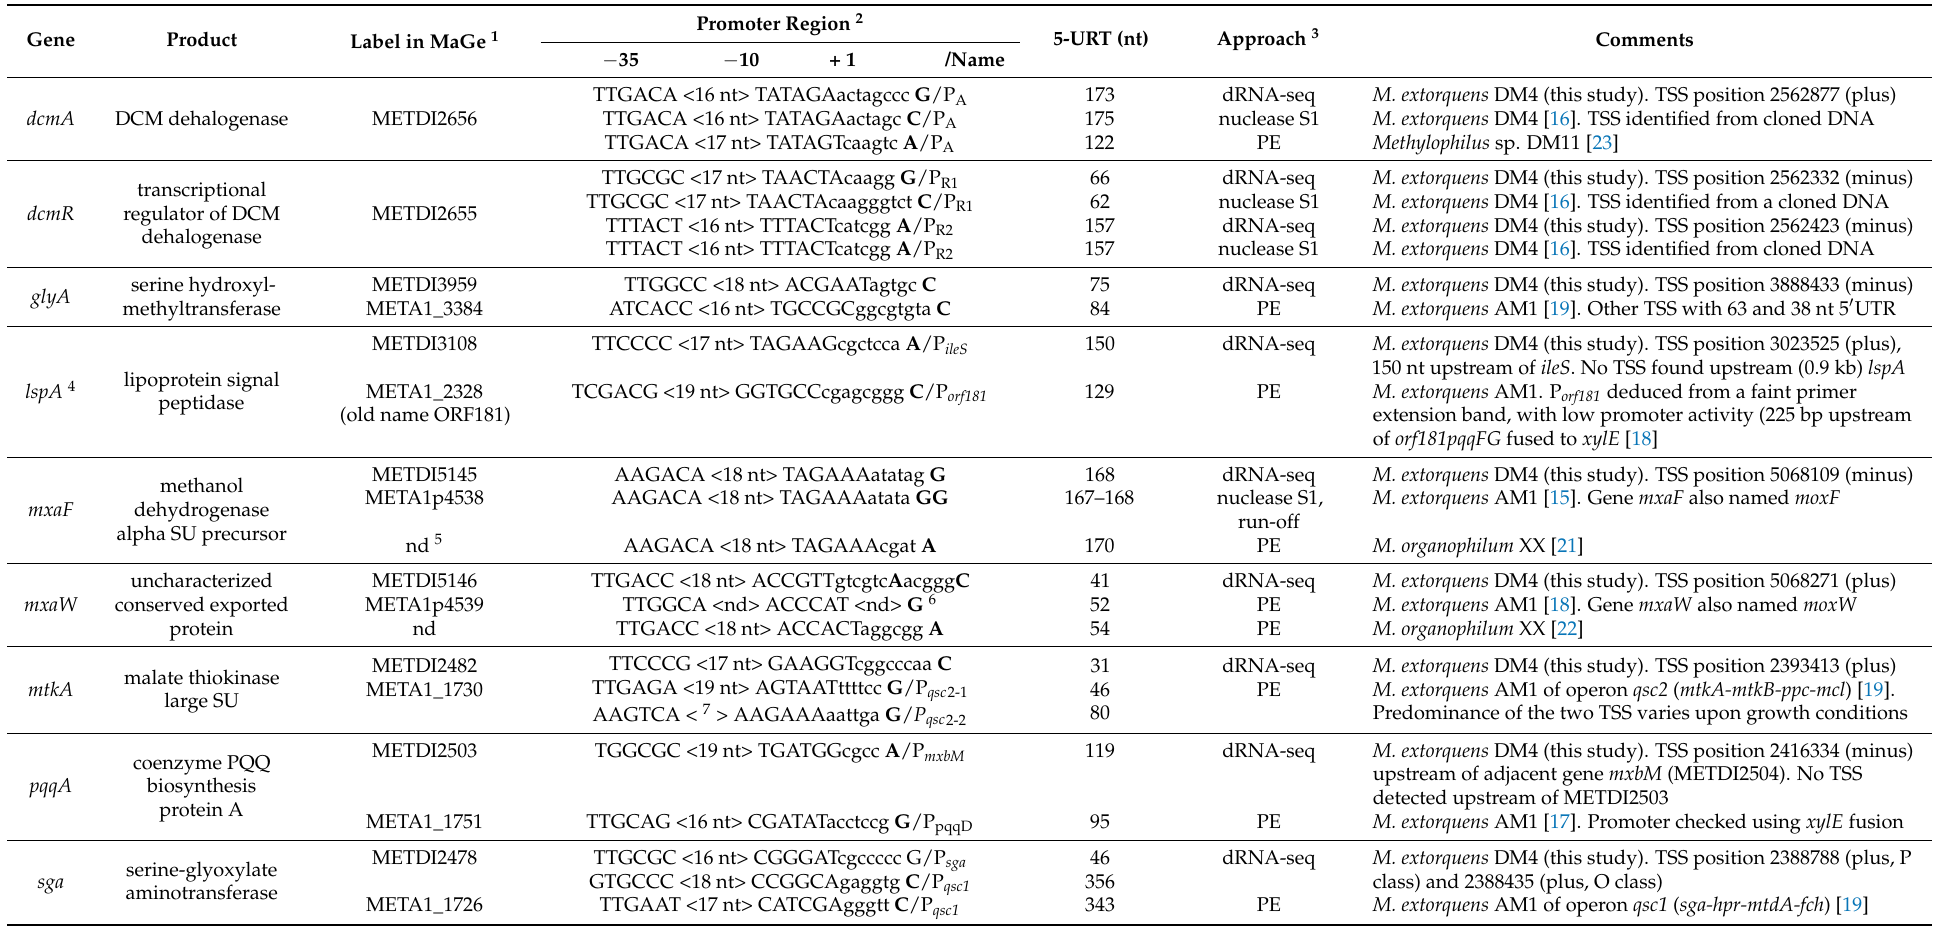
Table 2. TSSs detected using dRNA-seq compared to previously mapped TSS with other